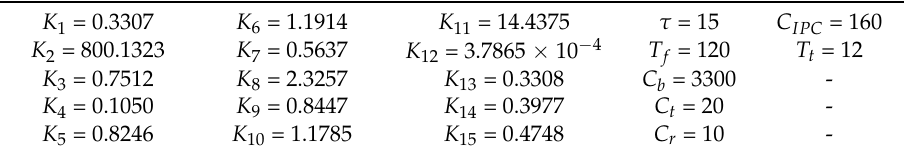
Table 3. Model parameters of a CHP unit with two-stage